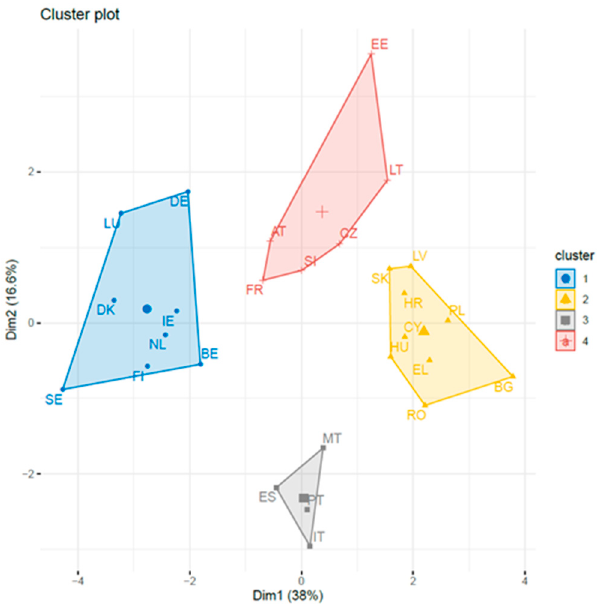
Figure 2. Cluster plot for 11 indicators of cancer deaths and 27 countries. Table 1. Cluster means for 11 indications and cancer